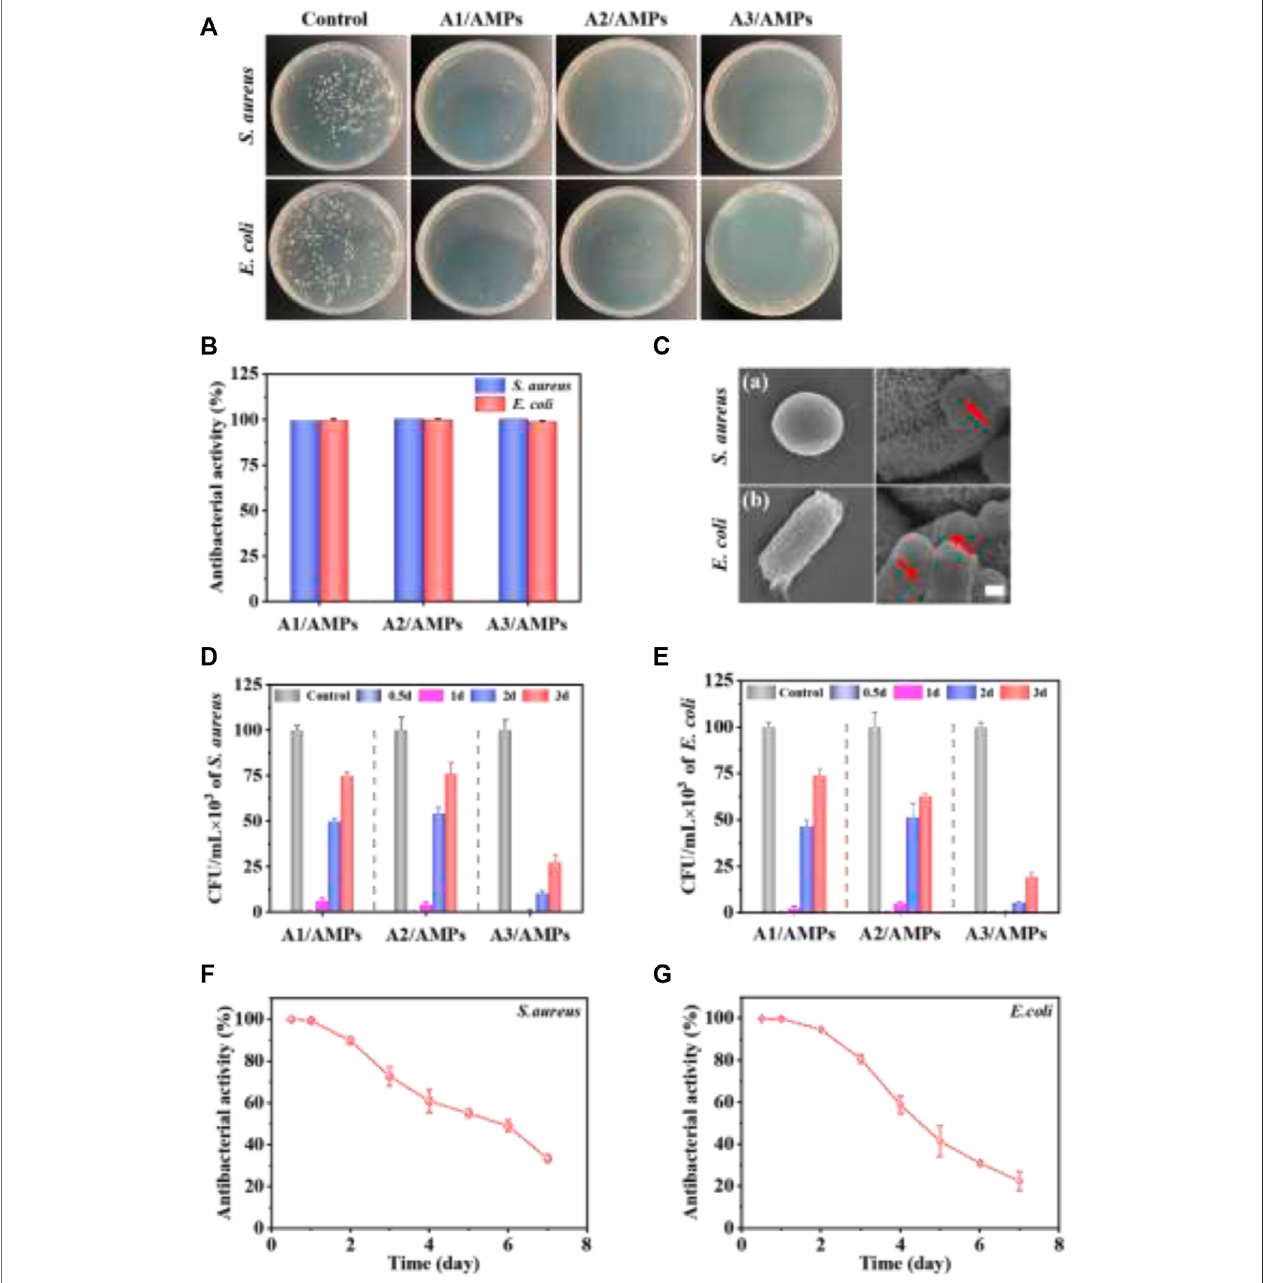
FIGURE6| Theevaluationofthe continuous antibacterialproperty ofdifferentHA/AMPs MSs. (A) Bacterialcoloniesformationafter culturewithHA/AMPsMSs for 2 h. (B) Antibacterial activity of the HA/AMPs MSs at 2 h. (C) SEM images showed the changes of bacterial membrane after culture with A3/AMPs MSs for 2h, bar (cid:2) 0.5 µm. (D,E) AntibacterialactivityofthreeHA/AMPsMSsatdifferenttimepointsof0.5,1,2,and3 days.ThecontrolgroupwasculturedwithHAMSsextract. (F,G) The long-term antibacterial performance of A3/AMPs MSs from 0.5 to 7 days.